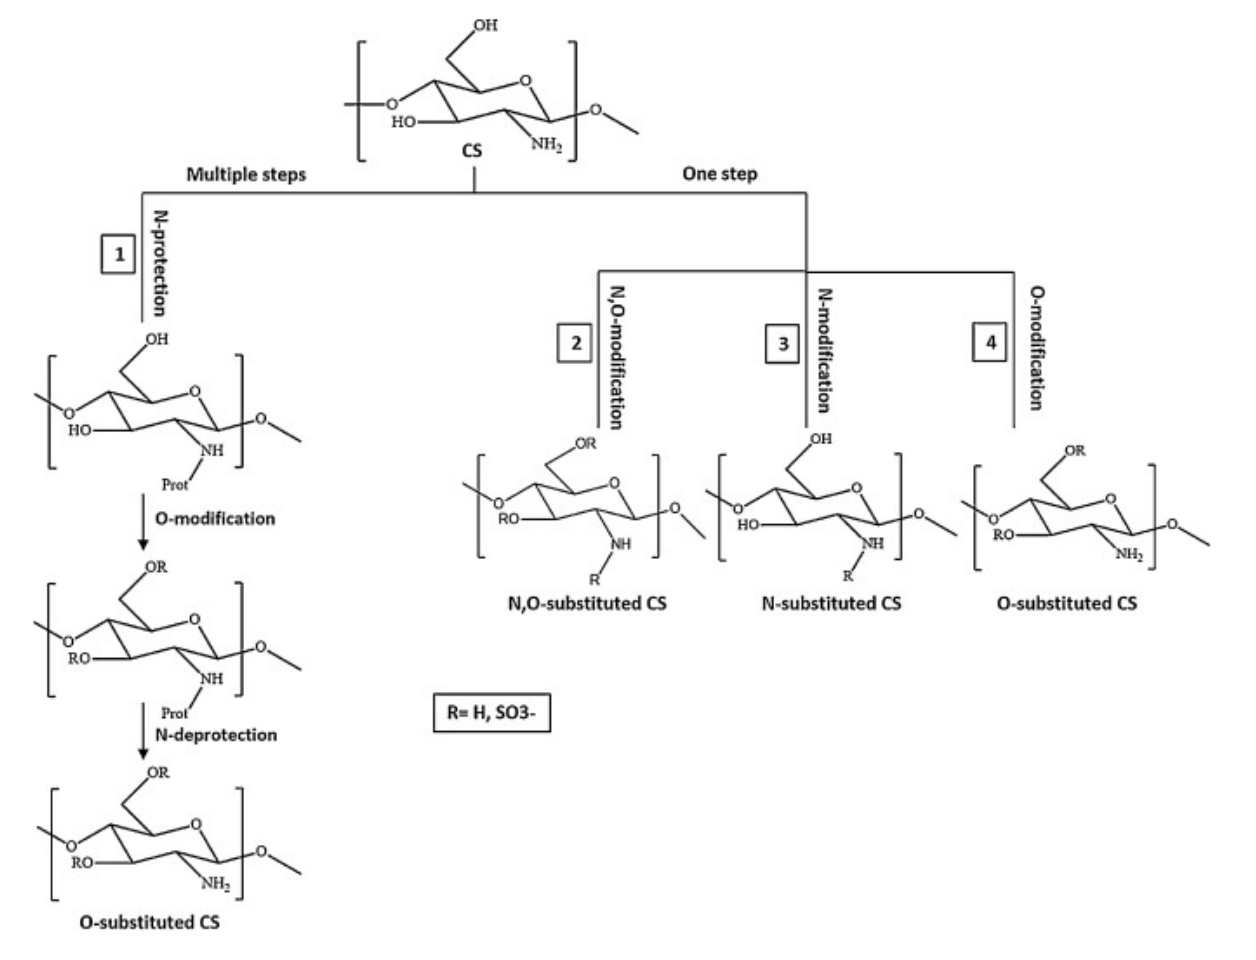
Figure 6. Synthesis of sulfated chitosan [217]. Reproduced with permission from Elsevier (Copyright © 2018).